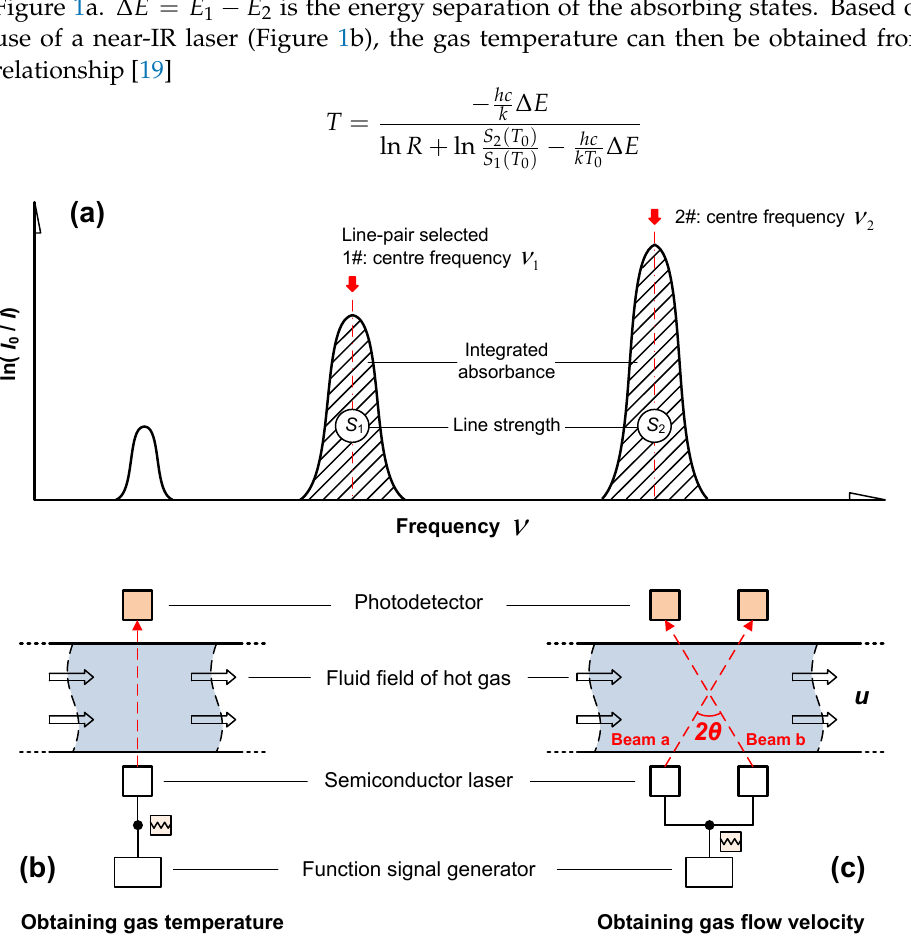
Figure 1. ( a ) Integrated absorbances of two selected transitions and diagrams summarizing the processes used to measure ( b ) gas temperature and ( c ) flow velocity.